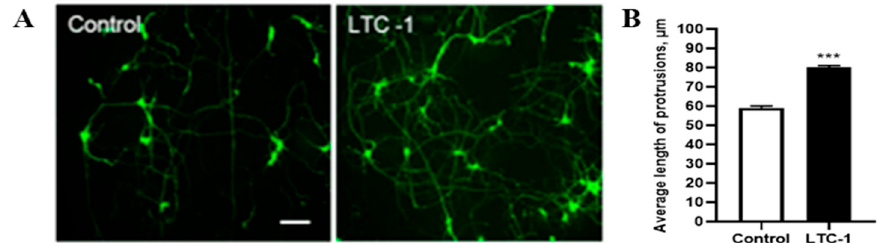
Figure 7. The length of dendrites of hippocampal neurons increased after treatment with LTC1. ( A ) The growth status of hippocampal neuron dendrites 24 h after drug treatment. Ruler = 20 µ m; ( B ) statistical graph of dendritic length 24 h after administration. The mean (SD) is used to express the data. One-way ANOVA was used for statistical analysis, followed by Tukey’s multiple comparison test, *** p < 0.001 vs. control.